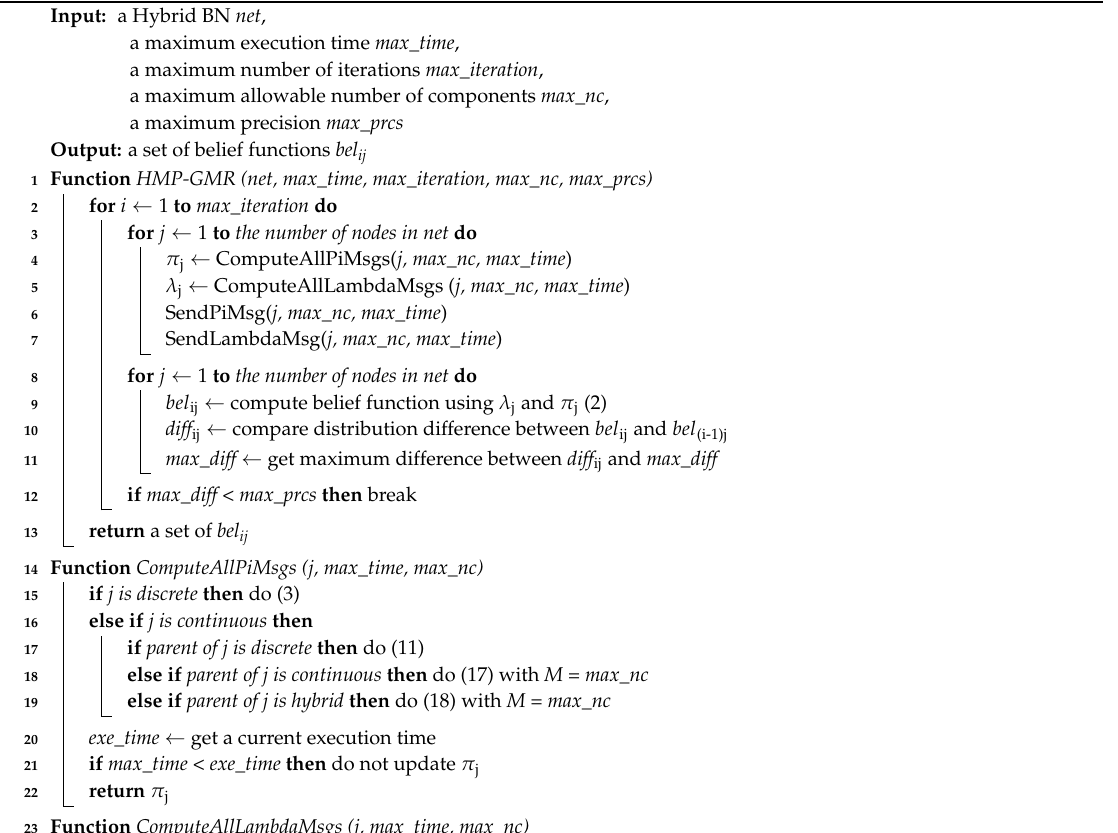
Algorithm 1: Hybrid Message Passing (HMP) with Gaussian Mixture Reduction (GMR)